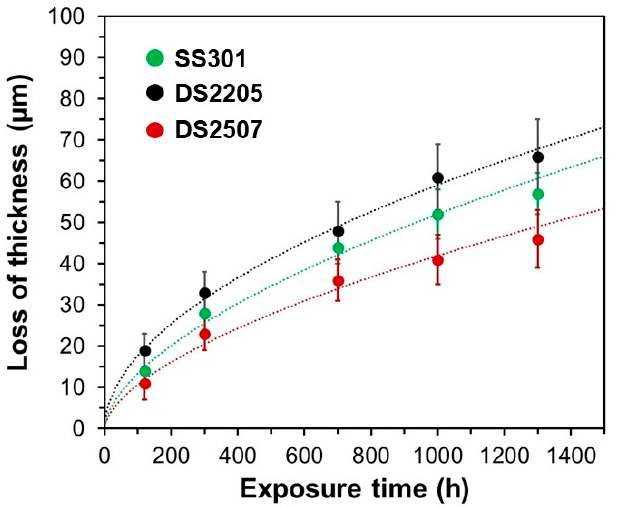
Figure 1. Evolution of thickness loss of SS301, DS2205 and DS2507 as a function of the exposure time in molten salts. The dot lines indicate the tendency curve of thickness loss for each alloy obtained using Equation (2).